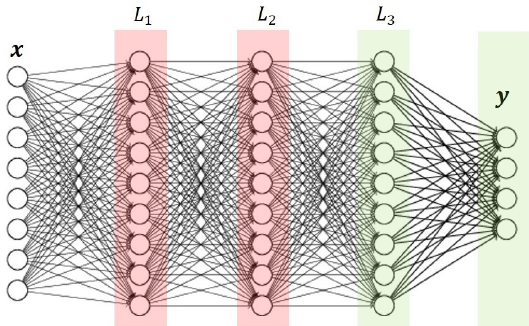
Figure 3. Schematic illustration of ANN architecture with parameter transfer. Parameters from the first two layers are fixed (red), while last two layers are retrained on the target data